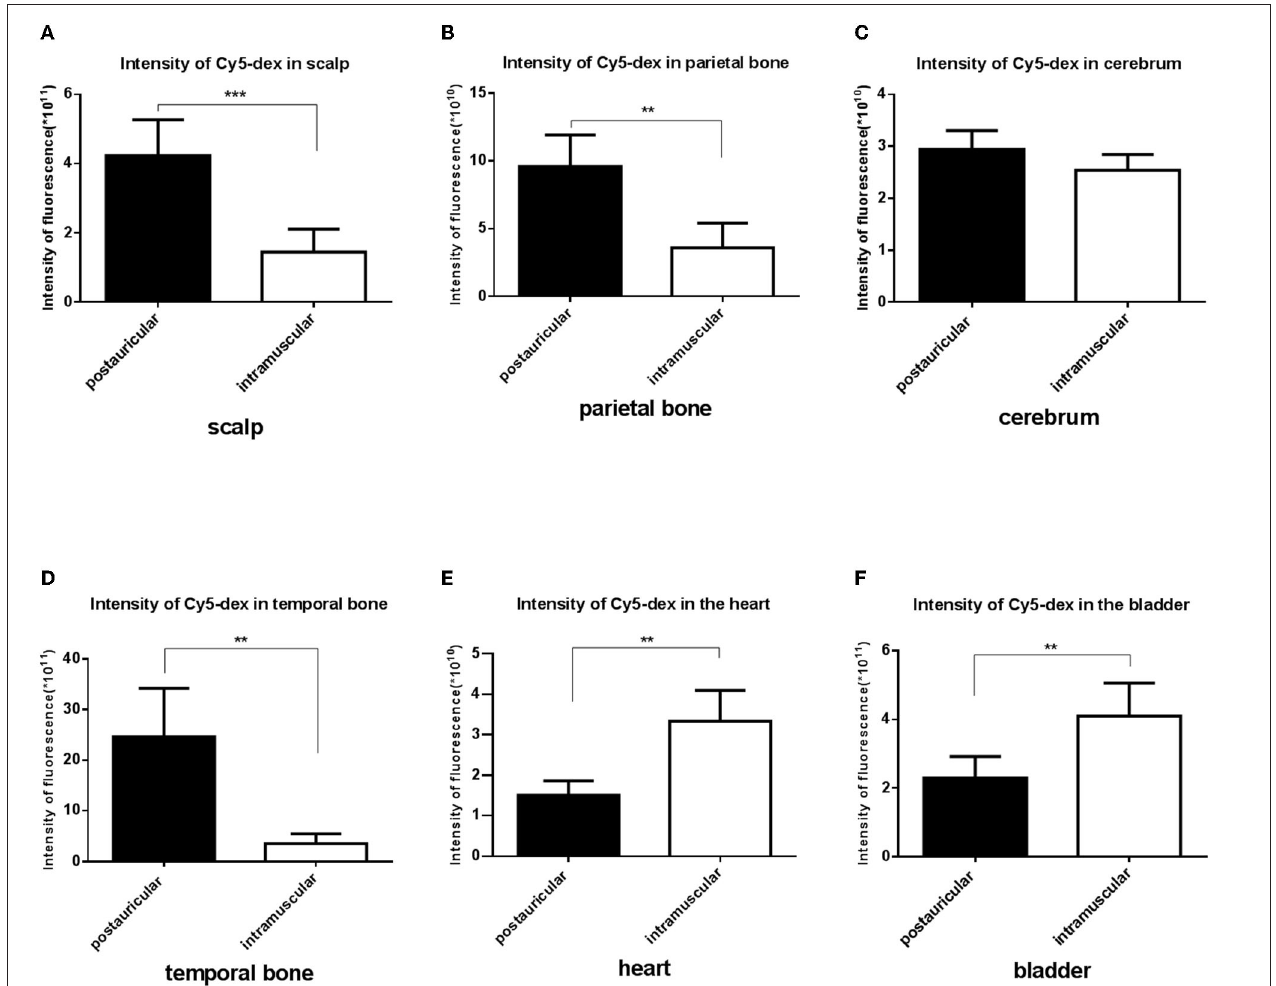
FIGURE 3 | Comparison of the fluorescent intensities of Cy5-dex between the postauricular and intramuscular injection groups in scalp (A) , parietal bone (B) , cerebrum (C) , temporal bone (D) , heart (E) , and bladder (F) . ** P < 0.05; *** P < 0.01.